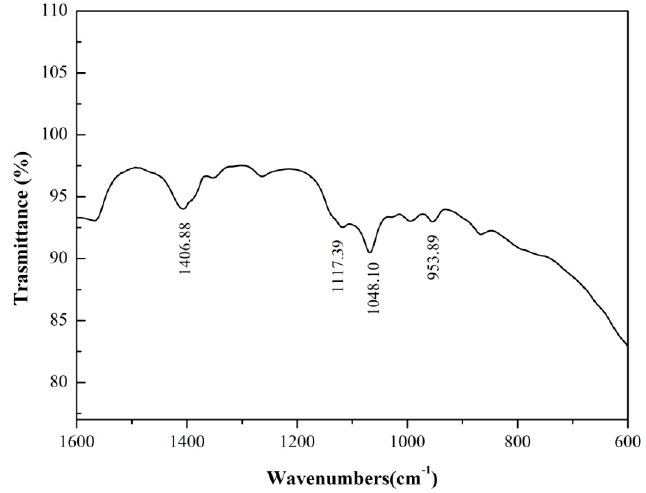
Figure 11. FTIR spectra of pyrrhotite after reacting with NaBX at pH = 6.